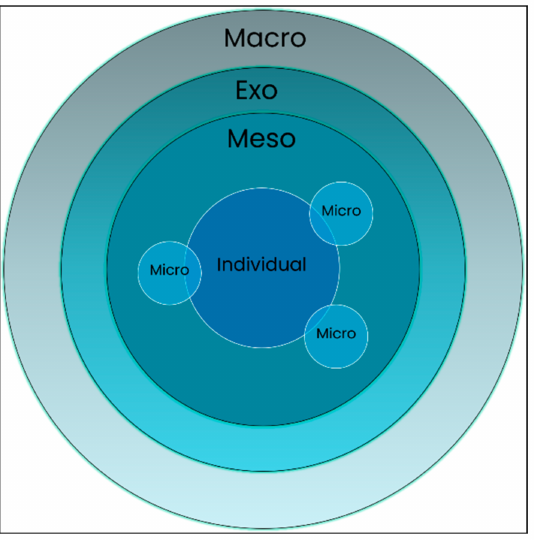
Figure 1. Bronfenbrenner’s “nested systems”, as conceptualised in Ecological Systems Theory